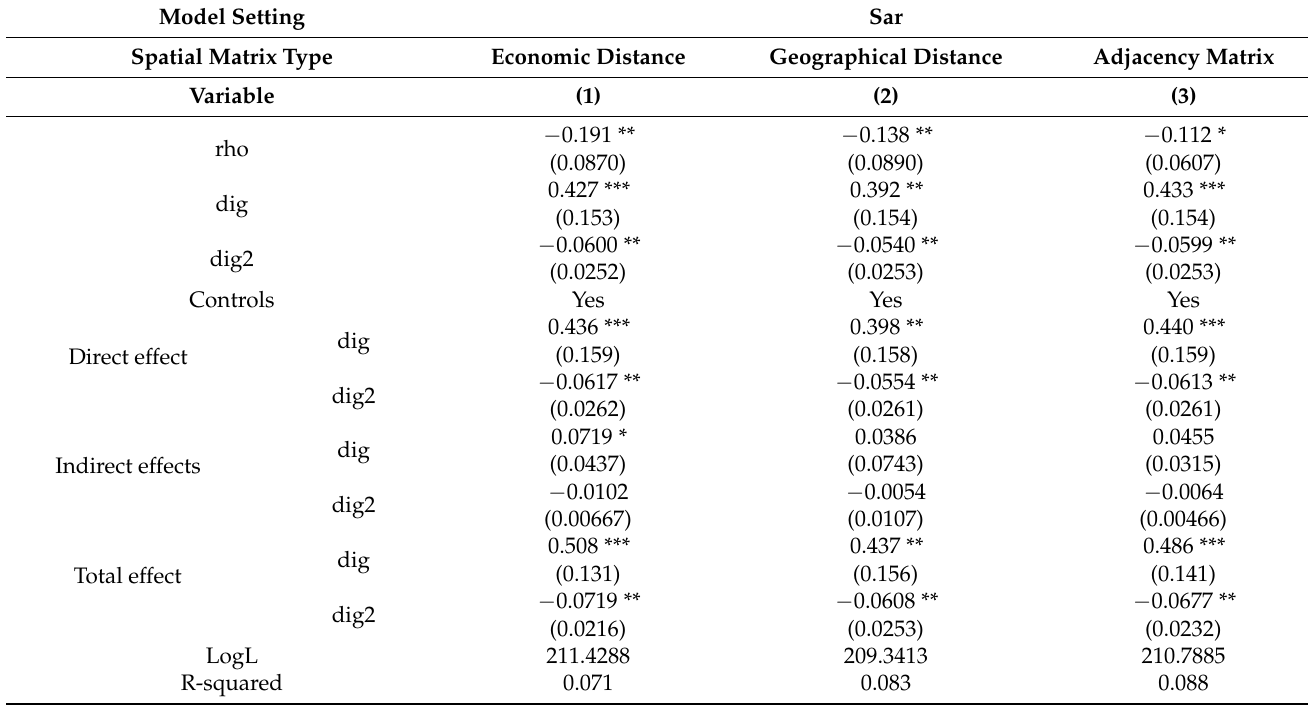
Table 11. Robustness test of the spatial spillover effect of digital innovation level affecting carbon emissions in the transportation